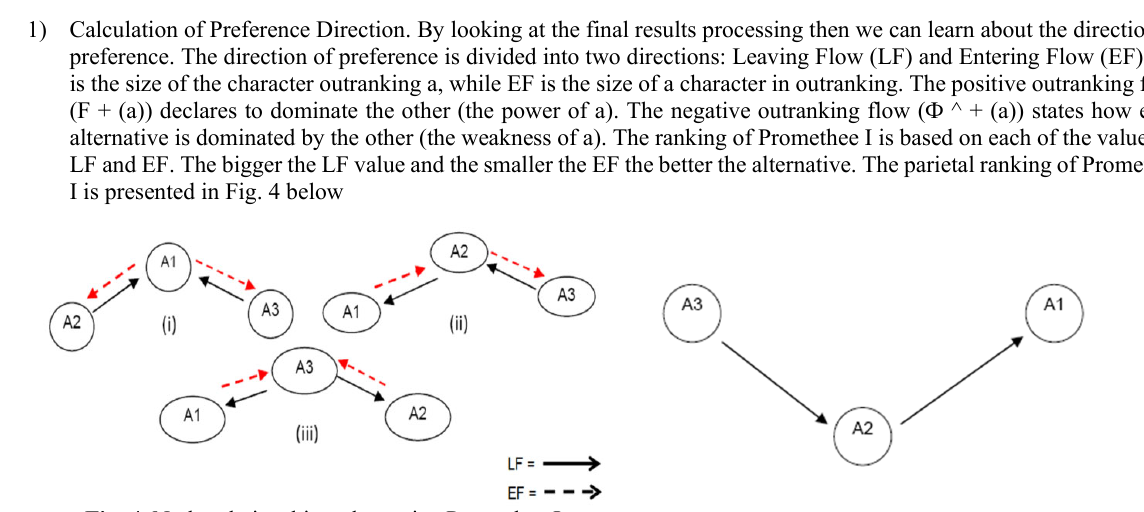
Fig. 4. Node relationship - alternative Promethee I Fig. 5. Node relationship - alternative Promethee